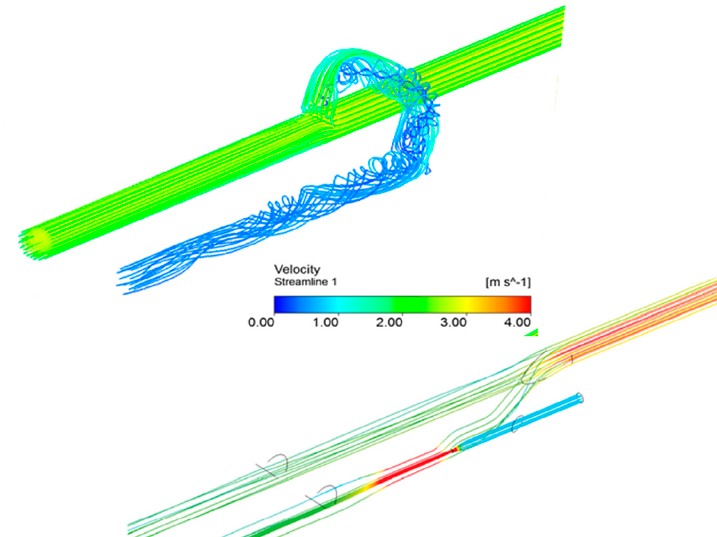
Figure 24. Streamline loop with and without pump.